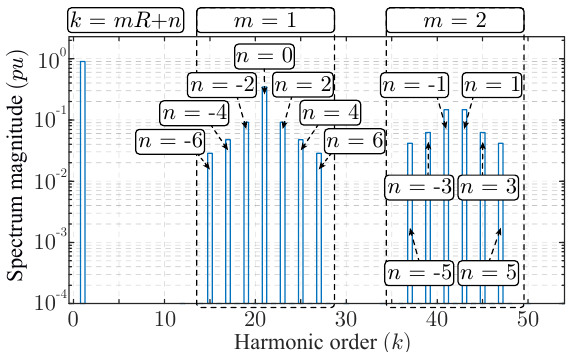
Figure 4. Harmonic spectrum definition of the